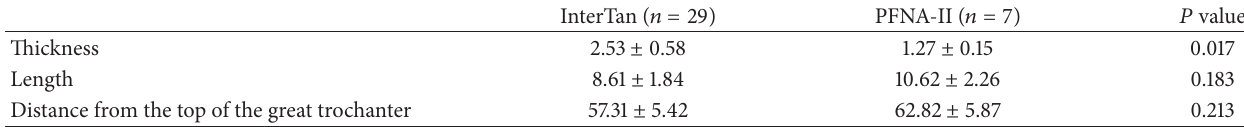
Table 1: The average fitness value of impingement on the proximal portion of the implant (mm).